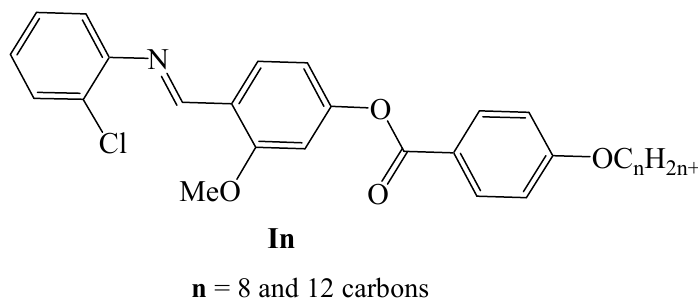
Figure 1. Molecular structures of investigated derivatives, In .